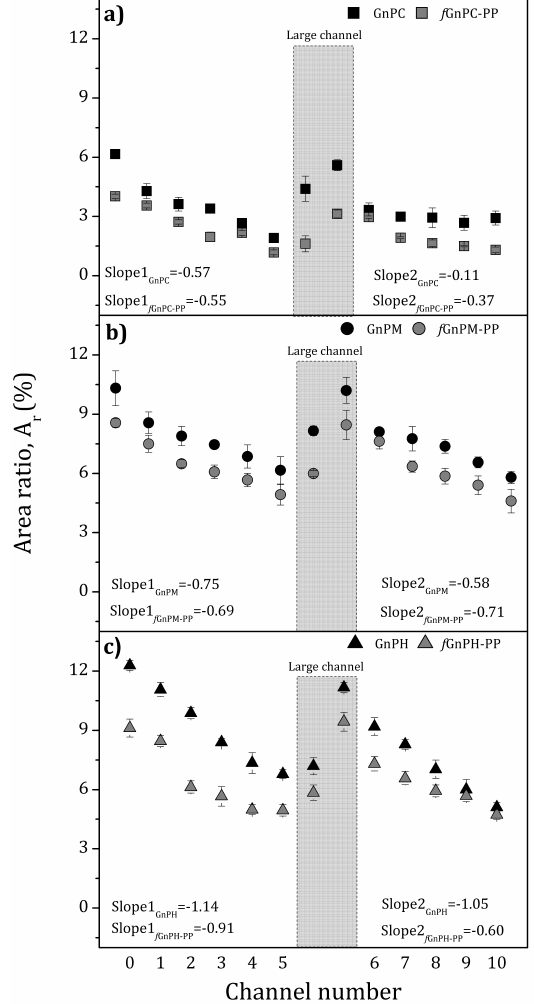
Figure 6. Evolution of dispersion (in terms of Area Ratio, A r ) along the length of the extensional mixer of GnP and f GnP-PP in a PP melt matrix.